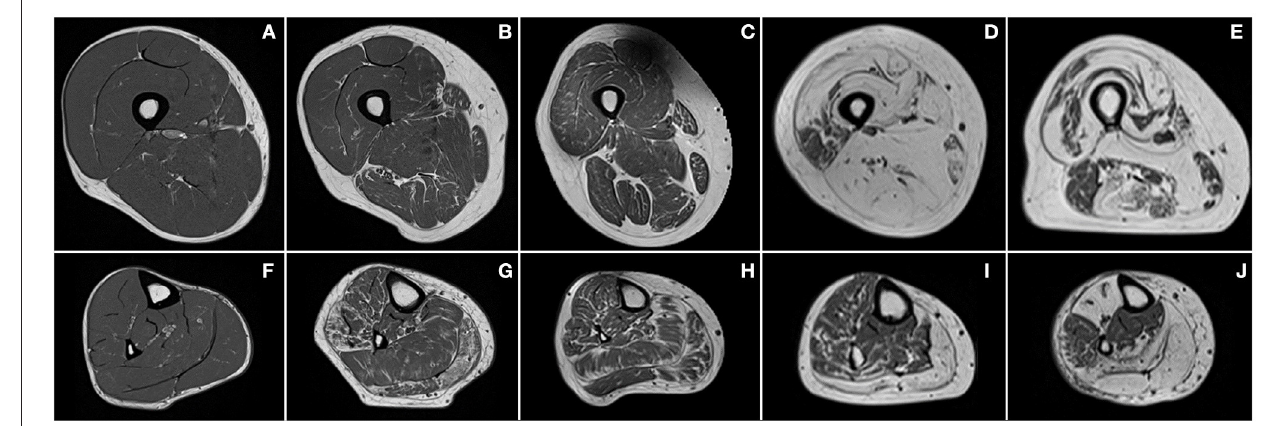
FIGURE 2 | Examples of T 1 -weighted images of thighs (first row) and lower legs (second row) of a healthy subject (A,F) and patients with Charcot–Marie–Tooth disease type 1A (B,G) , myotonic dystrophy type 1 (C,H) , facioscapulohumeral muscular dystrophy (D,I) , and inclusion body myositis (E,J)